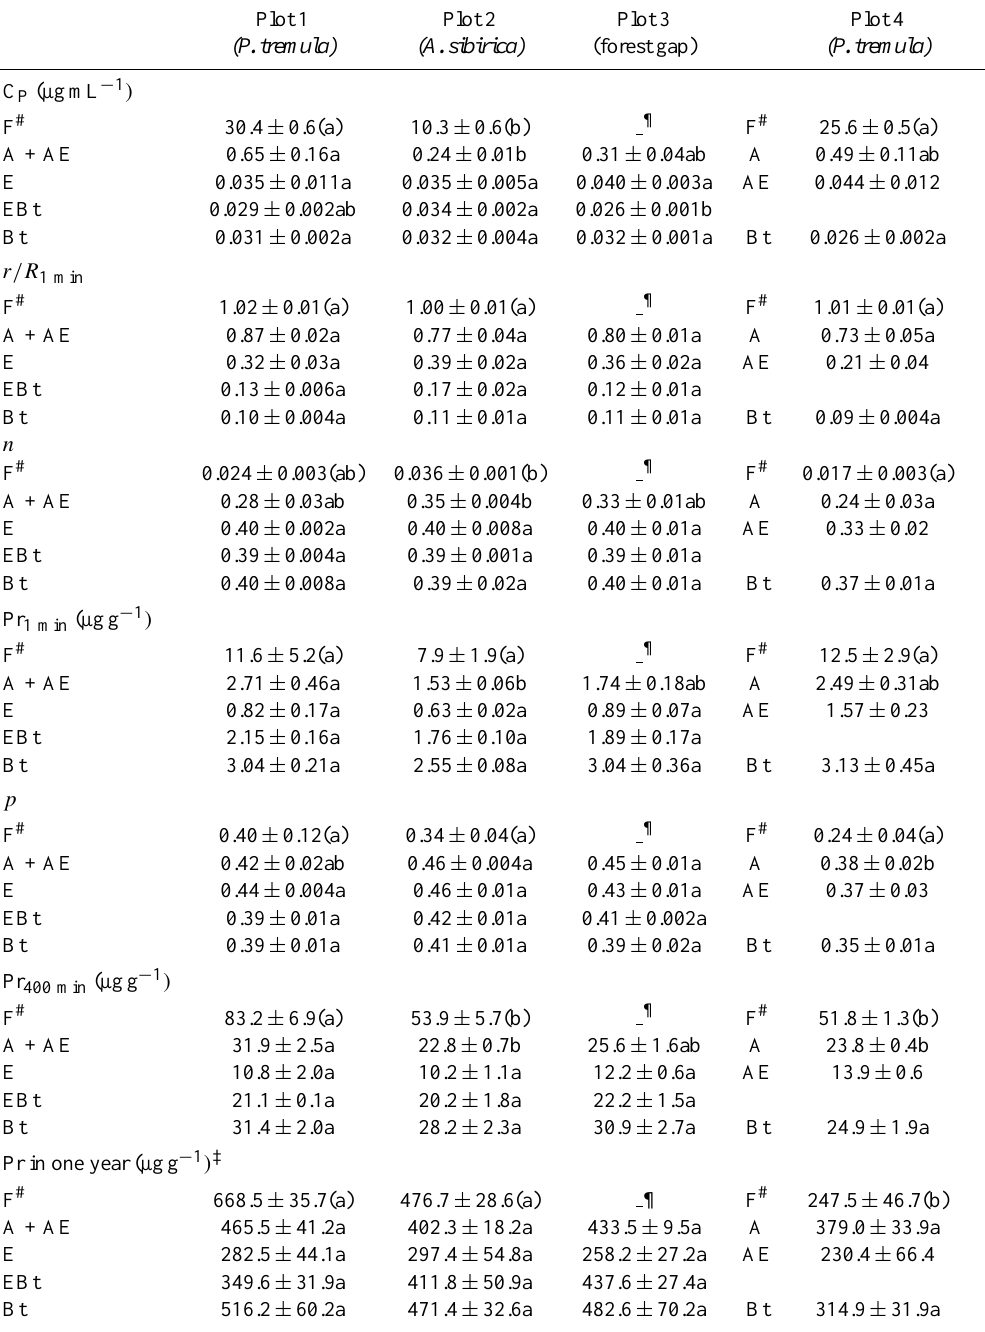
Means ± standard errors ( n obs = 3 zones per plot or 3 aliquots for each composite sample # ) . Different lowercase letters denote significant ( P < 0.05) differences between plots in a given soil horizon. Different lowercase letters in parentheses denote significant ( P < 0.05) differences between composite samples. Significant depth effect in each plot ( P < 0.04), except for parameter p in plot 1 ( P = 0.84). § Eq. (5); r 2 = 0 . 794 − 0 . 999 for the forest floors and 0.980–1.000 for the mineral soils ( P < 0.0001). † Eq. (6); r 2 = 0 . 832 − 0 . 994 for the forest floors and 0.951–1.000 for the mineral soils ( P < 0.0001). ‡ Using parameters